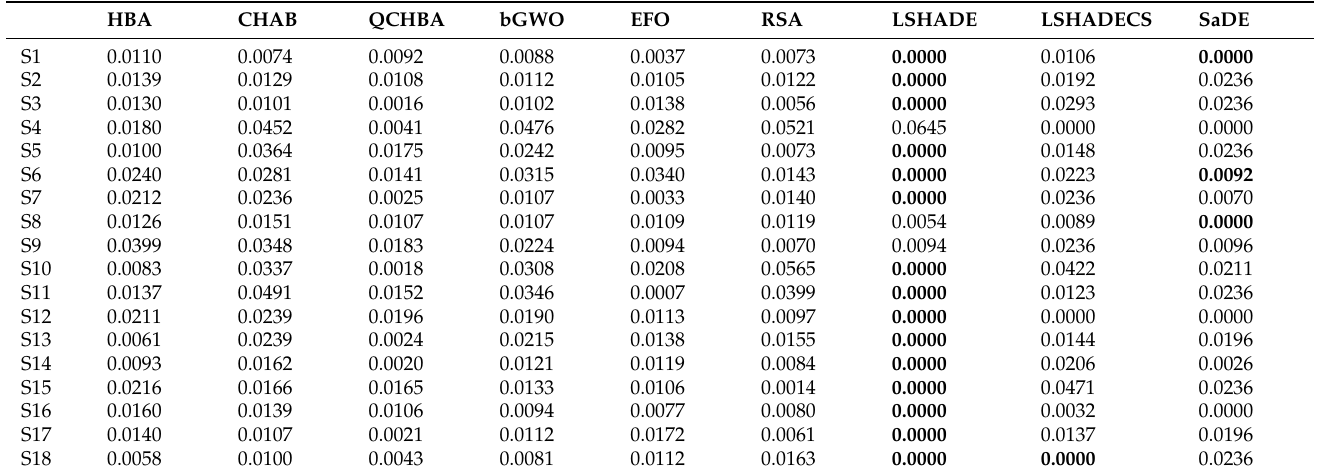
Figure 3. Average of stability results of QCHBA and other algorithms overall for the tested datasets. Table 3. Stability of competitive algorithms based on fitness